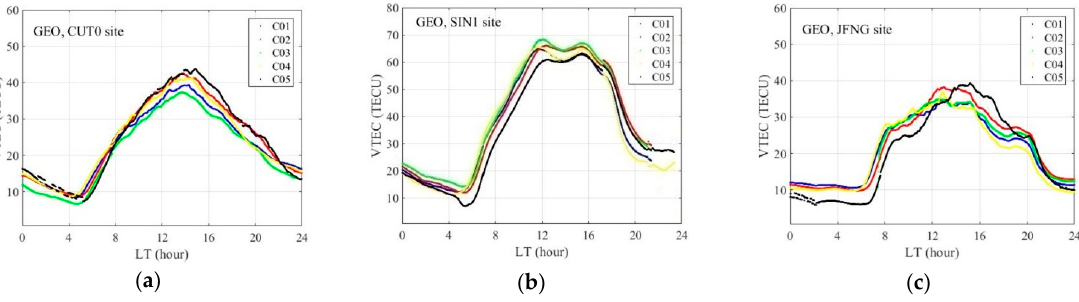
Figure 6. Diurnal variation of VTEC derived from five BDS GEO satellites on Day 004/2014. CUT0 ( a ), SIN1 ( b ), JFNG ( c ).